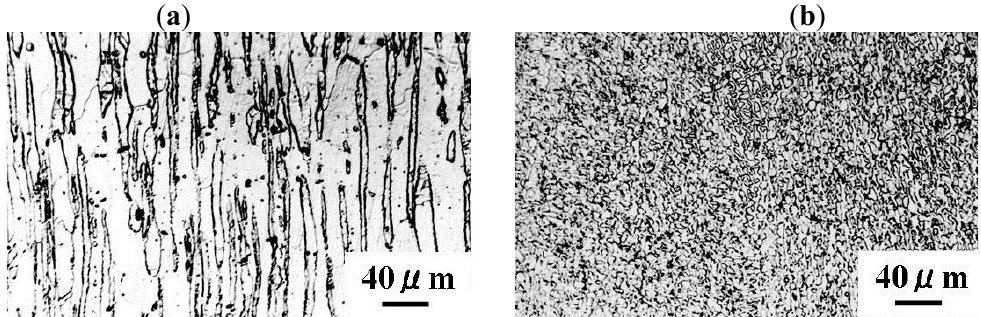
Figure 1. Microscopy image of the texture of ( a ) non-superplastic DSS and ( b )